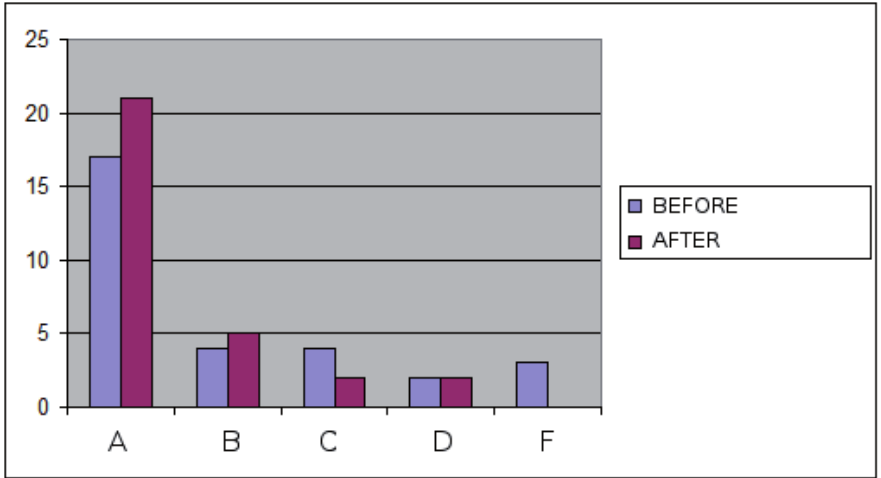
Fig. 4a. History grades in two  rst year classes of the School for Mechanical and Electrical Engineering Goša in Smederevska Palanka before and after the Project. Source: Own chart (Lajbenšperger, & Raji ć , 2013).